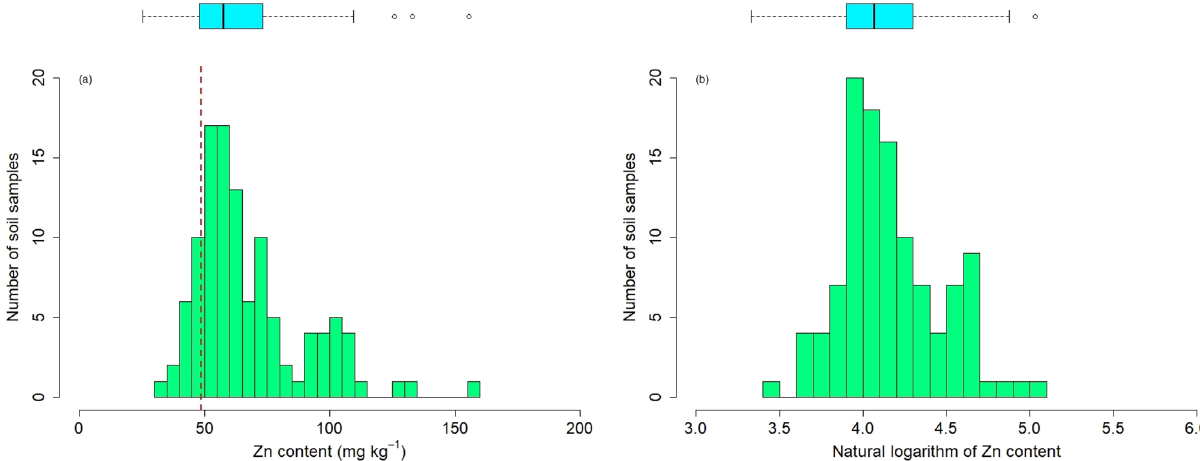
Figure 3. Histogram and box plot of Zn concentration of the topsoil in the study area (No. of samples = 111). (Note: Rad dashed curve is the soil Zn concentration background value of Inner Mongolia Autonomous Region, dashed circle denotes the outliers of soil Zn